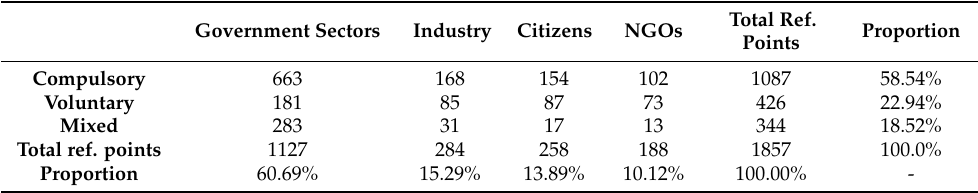
Table 6. Matrix Coding of Policy Tools and Policy